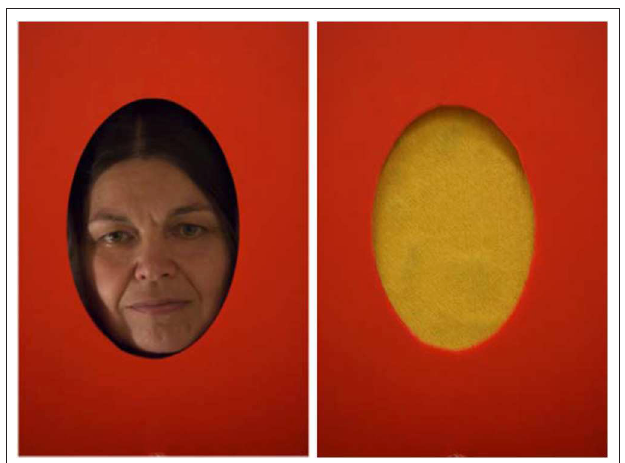
FIGURE 1 | Stimuli used in Study 1. The individual shown on the figure is an author of this paper and consented to the publication of their